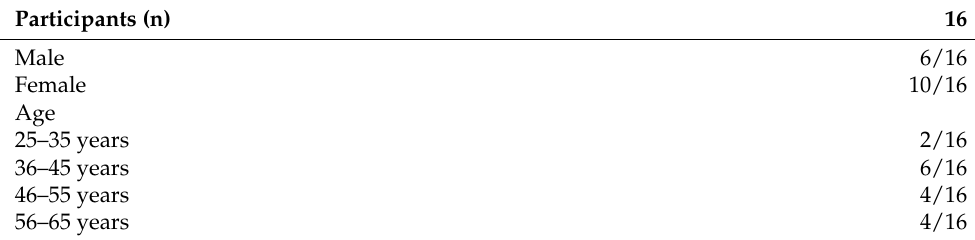
Table 3. Overview of the pharmacists’